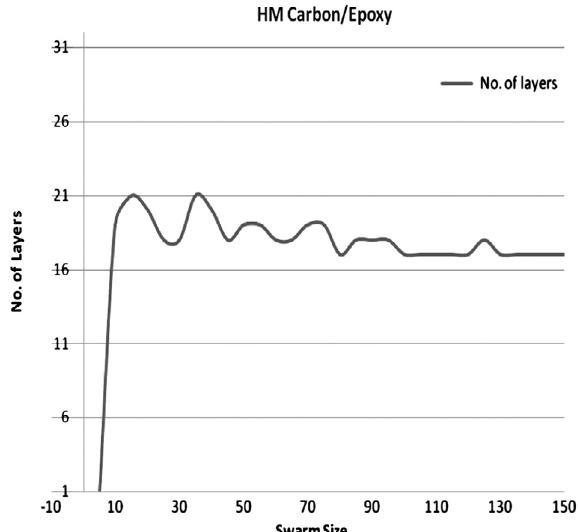
Figure 8. Variations of number of layers of HM Carbon/Epoxy drive shafts with swarm size.